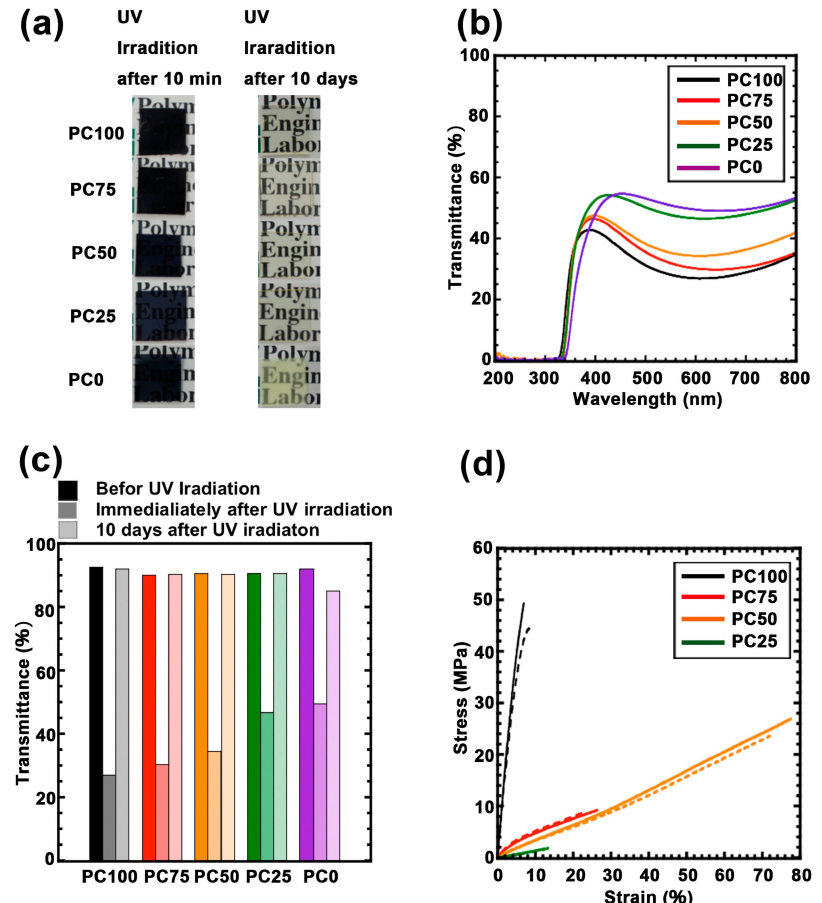
Figure 4. ( a ) Photograph of each polycarbonate/titania hybrid films immediately after UV irradiation and 10 days after UV irradiation. ( b ) UV-vis spectra of each polycarbon- ate/titania hybrid films immediately after UV irradiation PC100 (black line), PC75 (red line), PC50 (orange line), PC25 (green line), and PC0 (purple line). ( c ) Transmittance profile of each polycarbonate/titania hybrid film at 600 nm after UV irradiation: a lowest brightness is the films before UV irradiation, a medium brightness is UV irradiated films after 2 h, a highest brightness is UV irradiated films after 10 days, PC100 (black bars), PC75 (red bars), PC50 (orange bars), PC25 (green bars), and PC0 (purple bars). ( d ) Stress- strain curve for each hybrid film: the lines are before UV irradiated films, the dotted line is UV irradiated films after 10 days, PC100 (black bars), PC75 (red bars), PC50 (orange bars), PC25 (green bars), and PC0 (purple